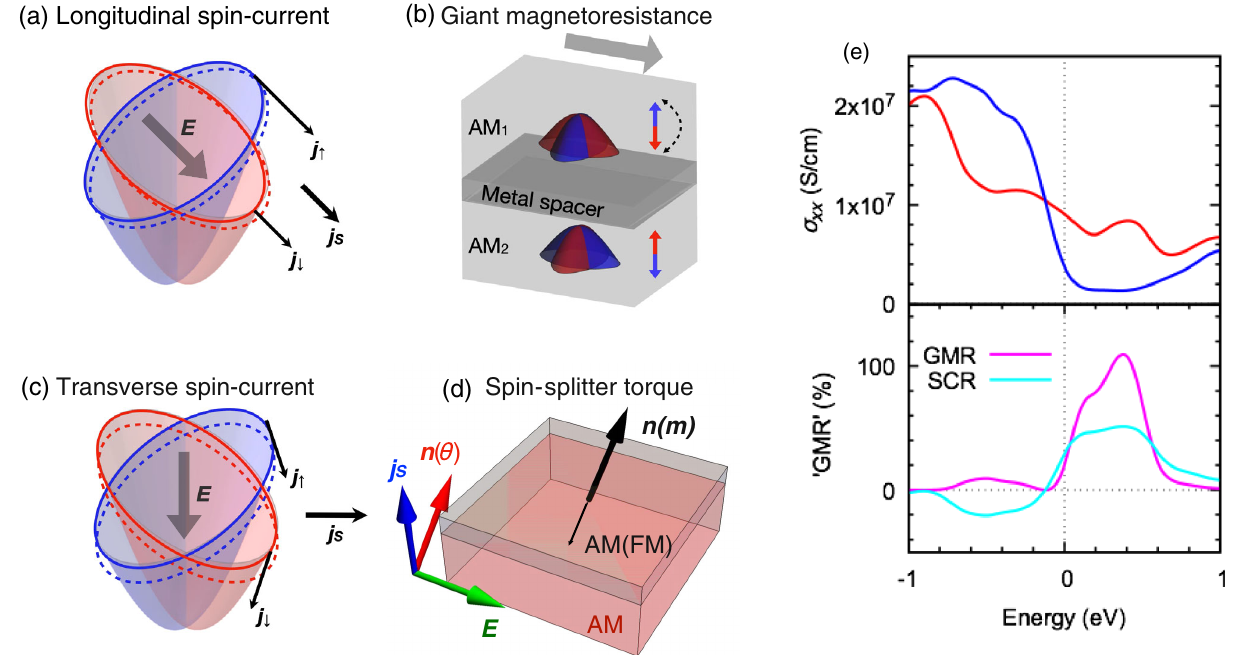
FIG. 12. (a) Schematics of the longitudinal spin current in altermagnets. For an electric bias E applied along one of the main anisotropy axes of the spin-split Fermi surfaces, the spin-up and spin-down charge currents are parallel but of different magnitudes due to the Fermi-surface anisotropies. As a result, the longitudinal charge current is spin polarized. (b) Schematics of a GMR stack in a current-in-plane geometry. As an example, we show the antiparallel configuration of the altermagnetic-order vectors in the two electrodes AM 1 and AM 2 . Interfaces are oriented along one of the main anisotropy axes of the spin-split bands. Energy band cuts highlight the anisotropy around the Γ point, resulting in anisotropic spin-dependent conductivities. (c) Schematics of the transverse spin current. For E applied in the diagonal direction between the two anisotropy axes of the spin-split Fermi surfaces, the spin-up and spin- down charge currents combine in an unpolarized longitudinal charge current and in a pure transverse spin current. (d) Spin-splitter- torque concept on a schematic of altermagnetic-altermagnetic (ferromagnetic) bilayer. A spin-current from the bottom altermagnet propagates in the out-of-plane direction and generates a spin-splitter torque on the altermagnetic (or ferromagnetic) order vector in the top layer. (e) Ab initio longitudinal spin-up and spin-down conductivities (red and blue), GMR, and the ratio of the transverse spin current relative to the longitudinal charge current (SCR) in RuO 2 . This figure is adapted from Refs.